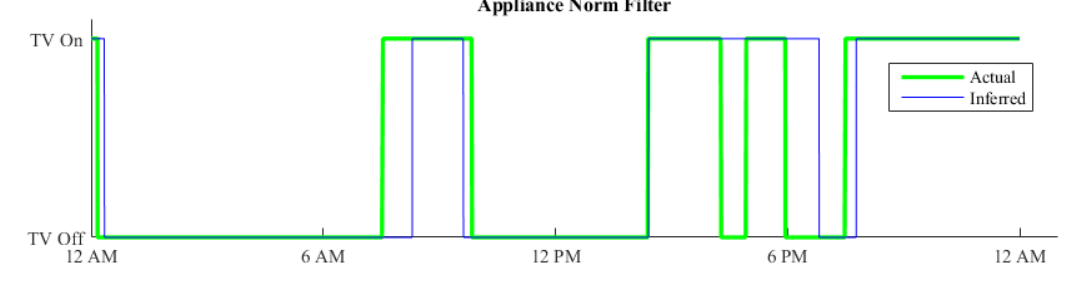
Figure 12. Purged and merged signal from a TV.